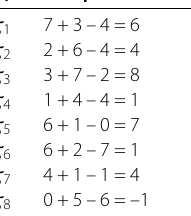
Table 3 fns -comparison table